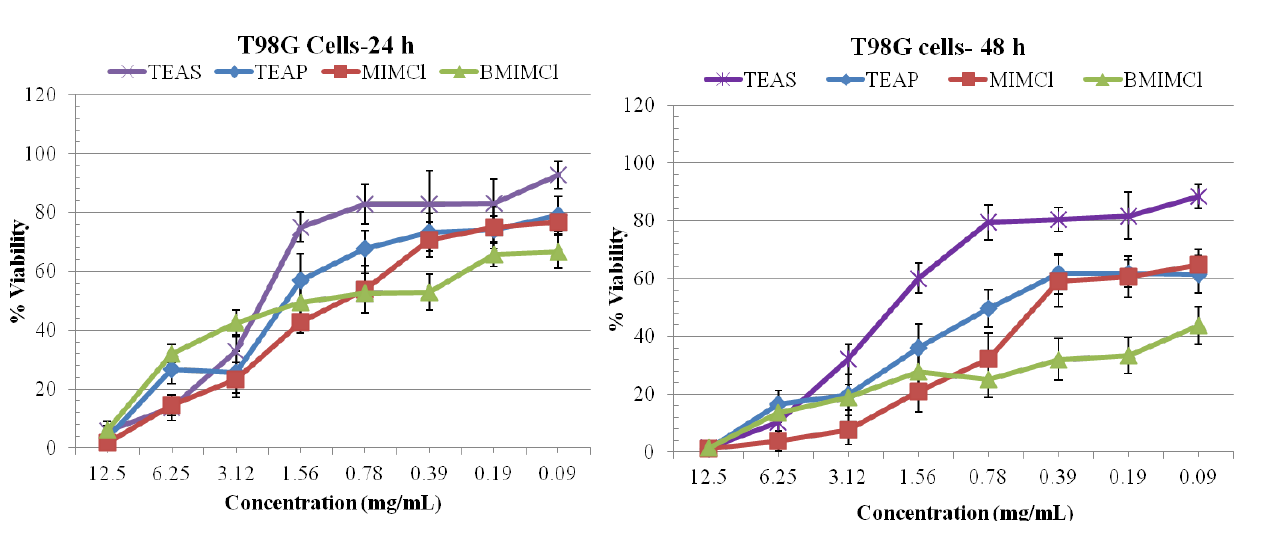
Figure 2. % Viability evaluated from MTT assay on T98G brain cancer cells treated